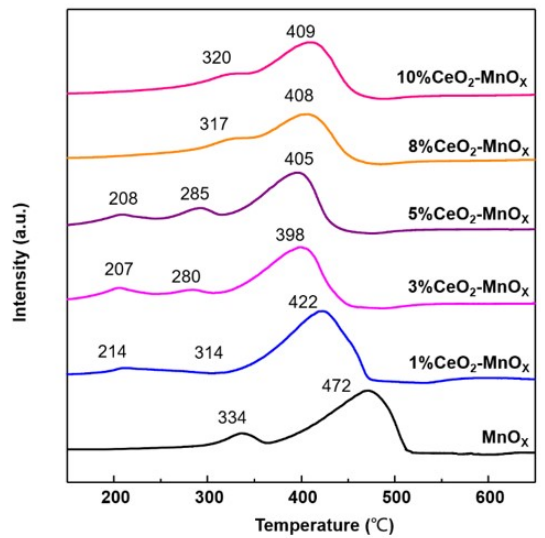
Figure 9. H 2 -TPR of w CeO 2 –MnO X loading.